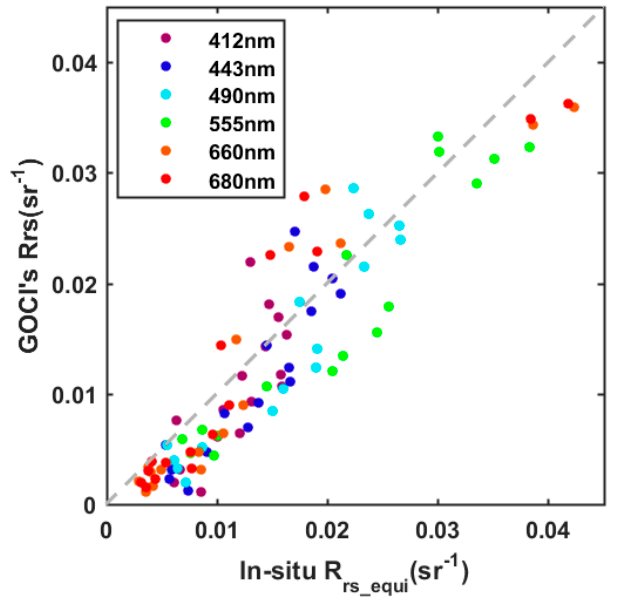
Figure 7. Evaluation of Level-2 data of the Geostationary Ocean Color Imager (GOCI). The colors of points represent different GOCI bands. Table 3. The coefficient of determination ( R 2 ), root-mean-square error (RMSE), and mean relative error (MRE) between the Geostationary Ocean Color Imager (GOCI)’s R rs and measured R rs_equi in different bands. R 2 RMSE R 2